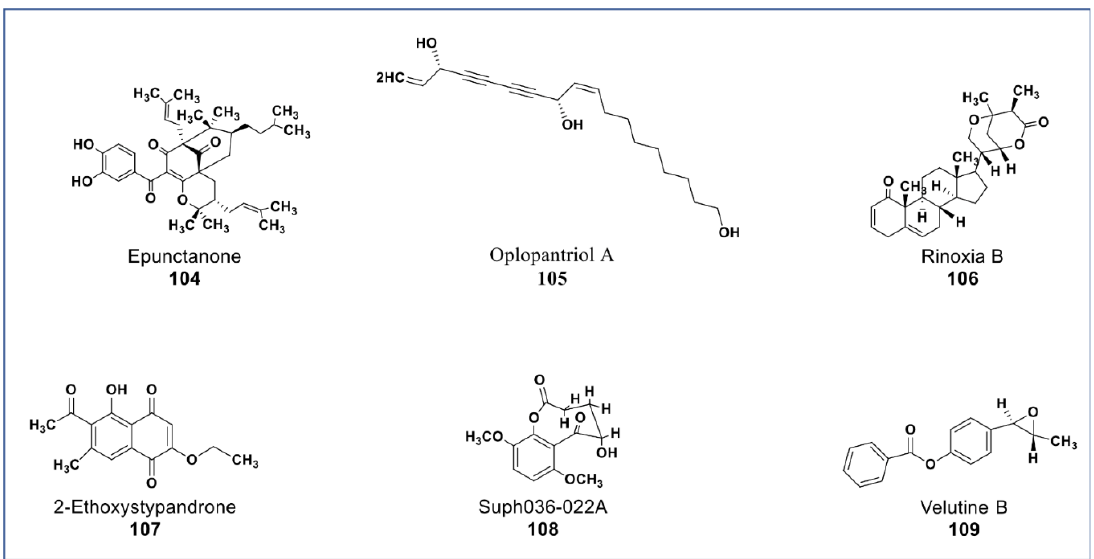
Figure 9. New phytochemicals belonging to different chemical classes. Polyenes, phytosterols, and a juglone analogue from various plant sources (compounds 104 to 109 ).